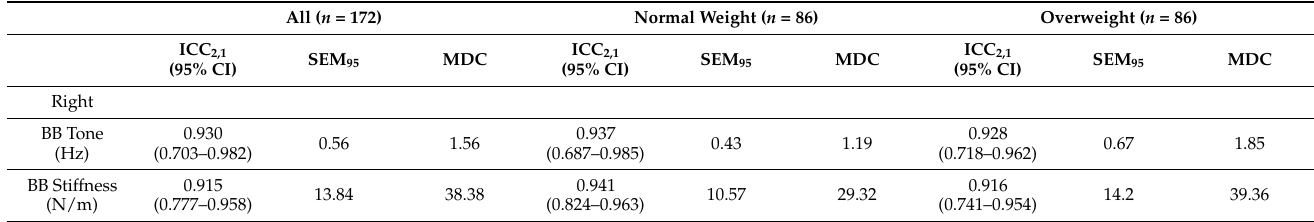
Table 2. Test–retest reliability results with SEM 95 and